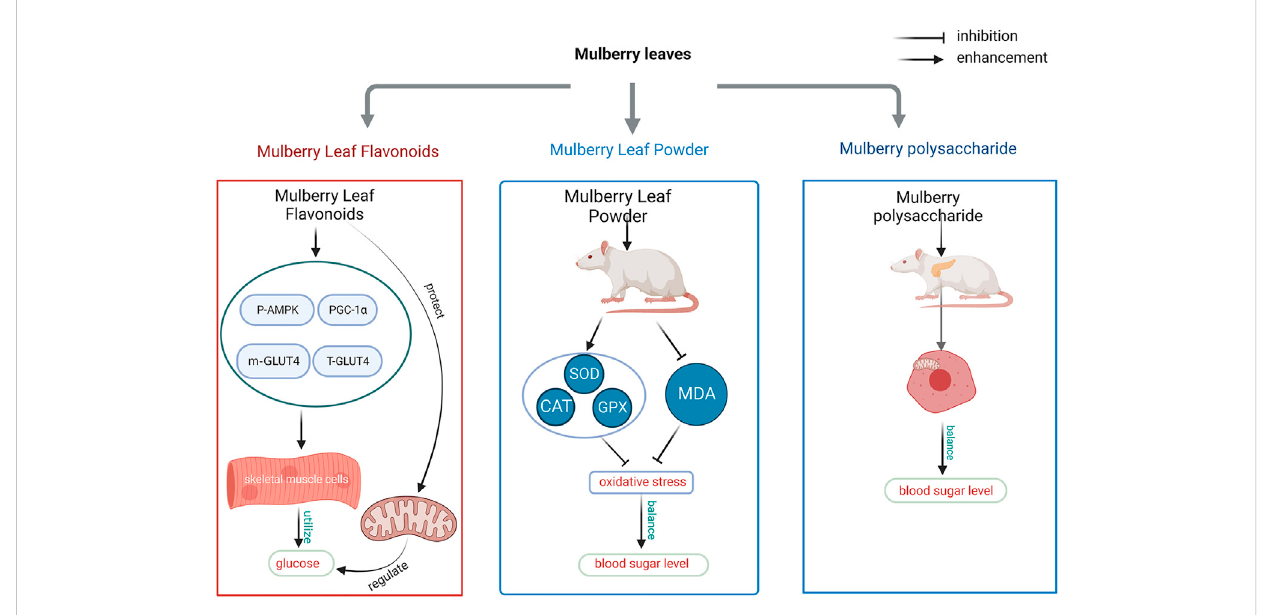
Mechanism of blood glucose regulation by improving oxidative stress in mulberry